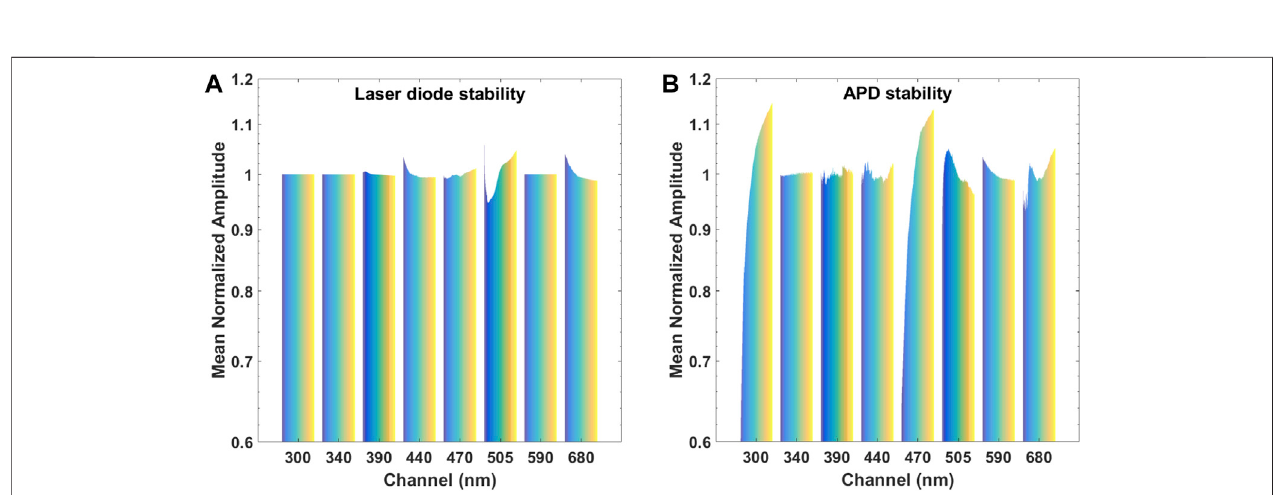
Frontiers in Physics |